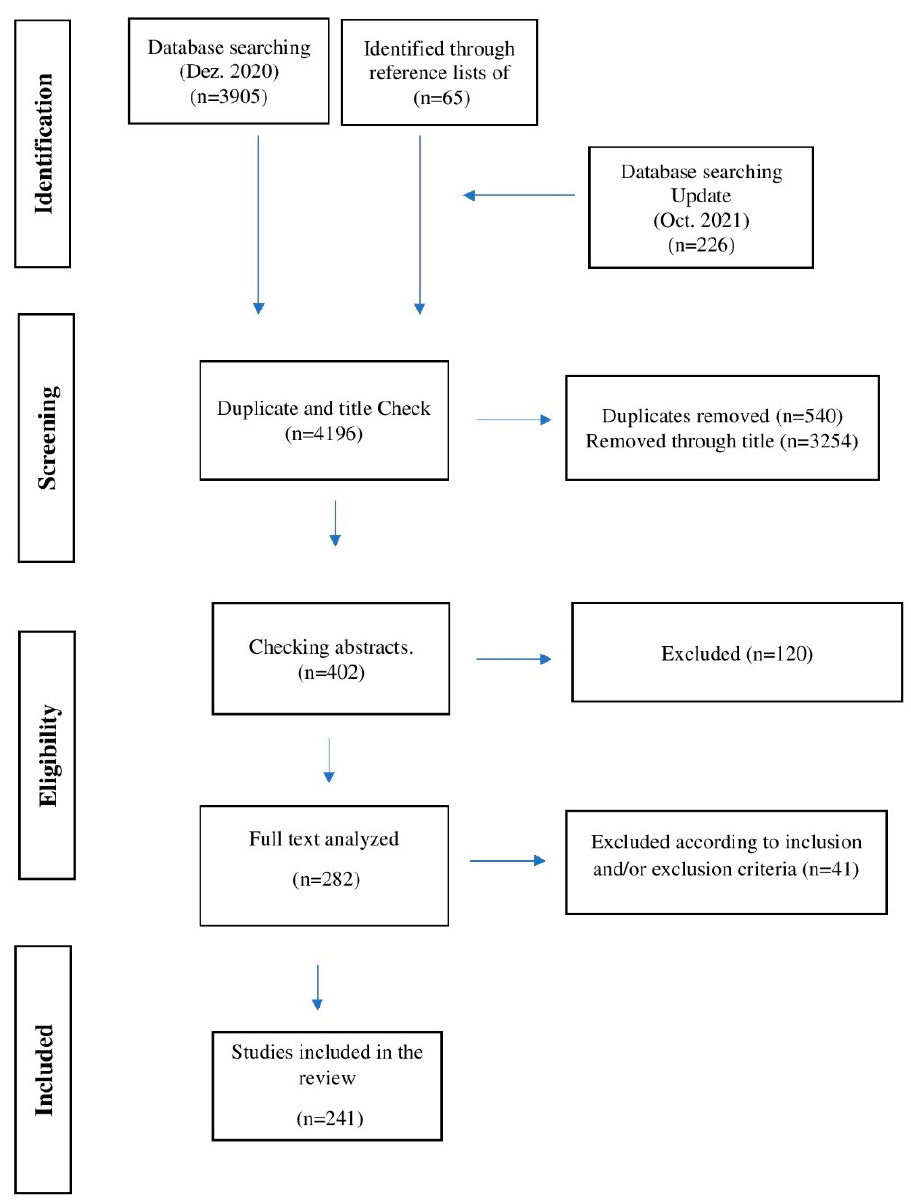
Figure 1. Flow diagram of database search.